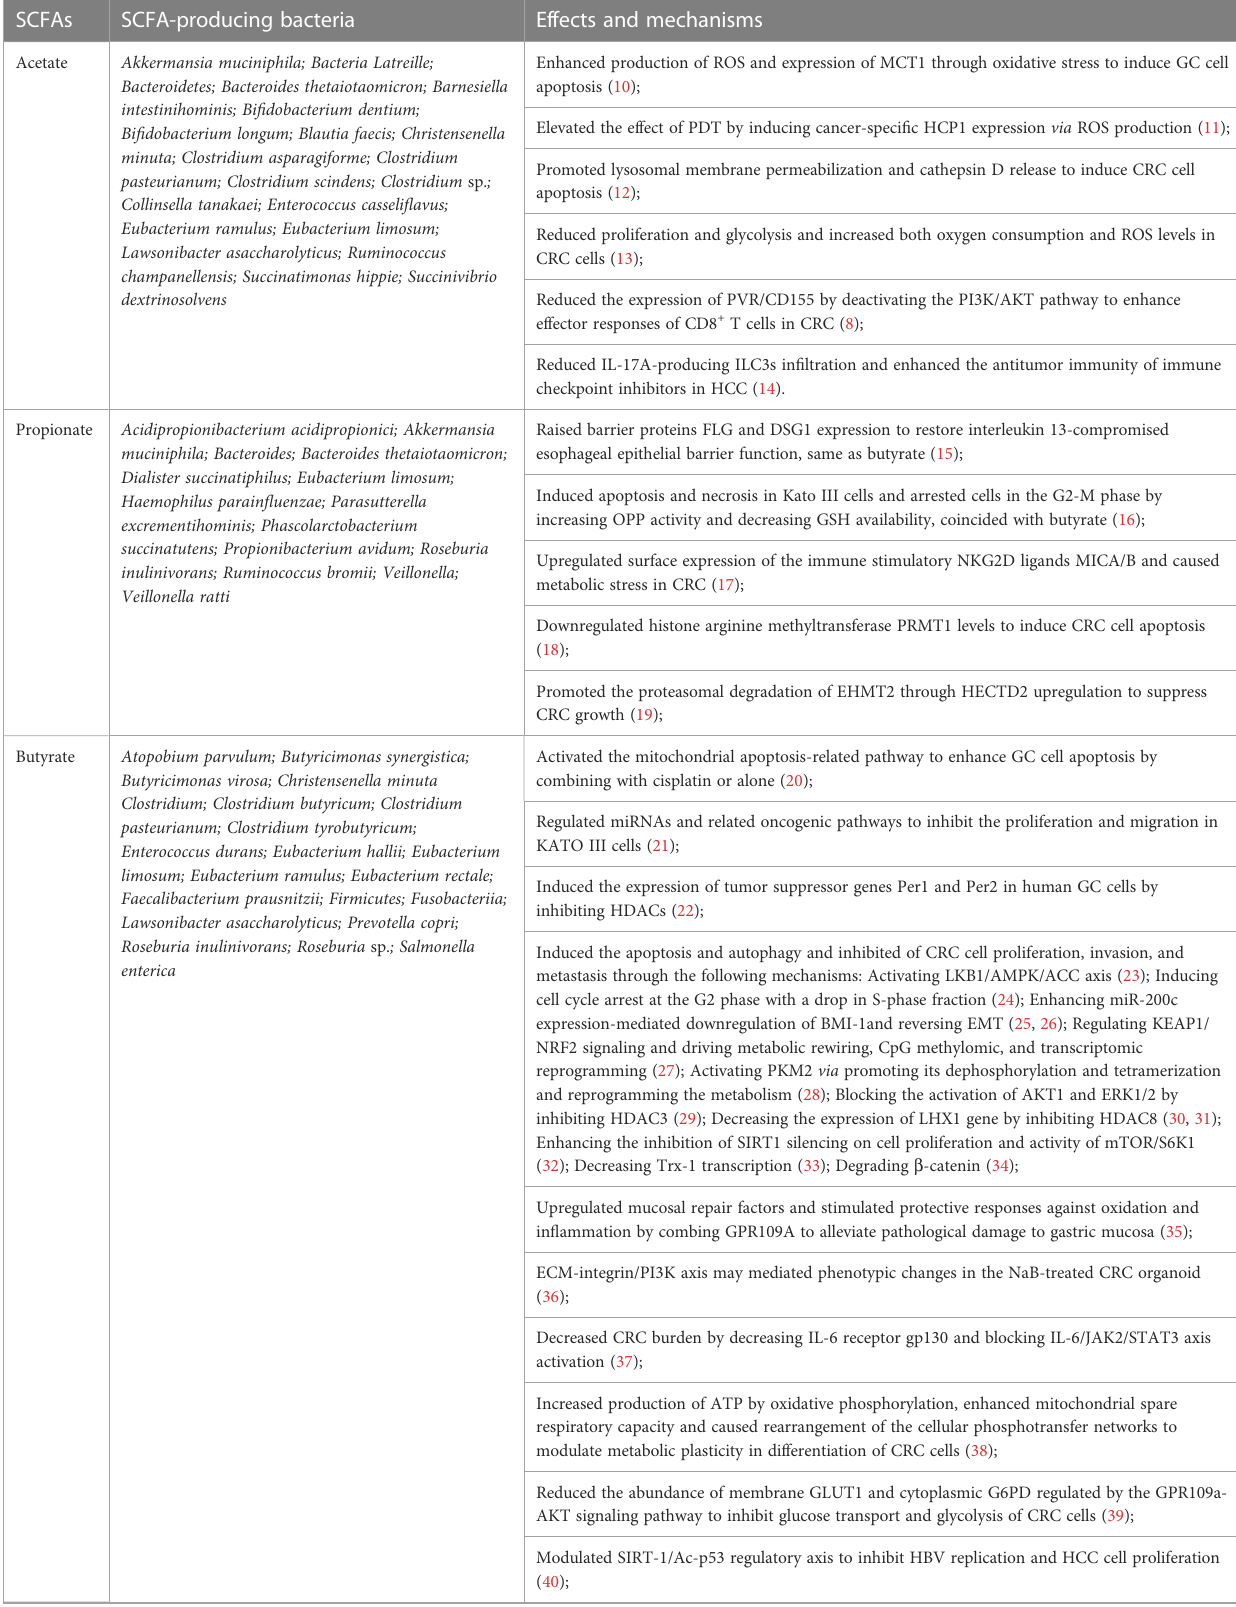
TABLE 1 Short chain fatty acids and associated-microbiota in tumor immune microenvironment. (Bacteria data sources: gutMGene). SCFAs SCFA-producing